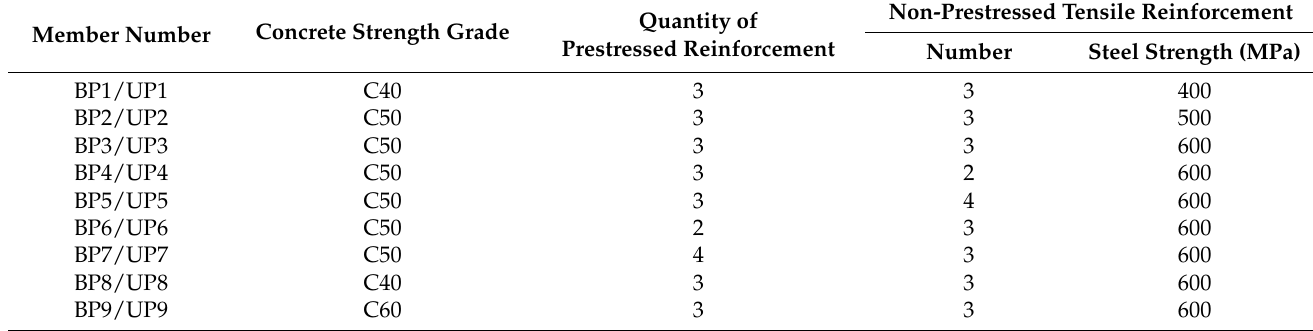
Table 1. Design parameters of each test beam.